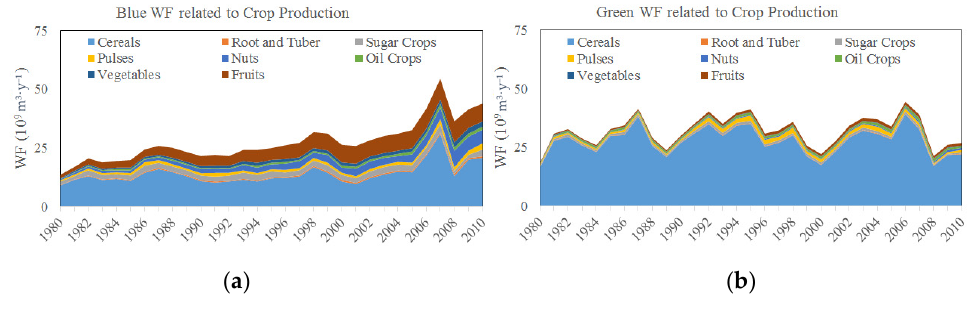
Figure 4. Blue WF ( a ) and green water footprint (WF) ( b ) and per tonne of crop production in Iran over the period 1980–2010.